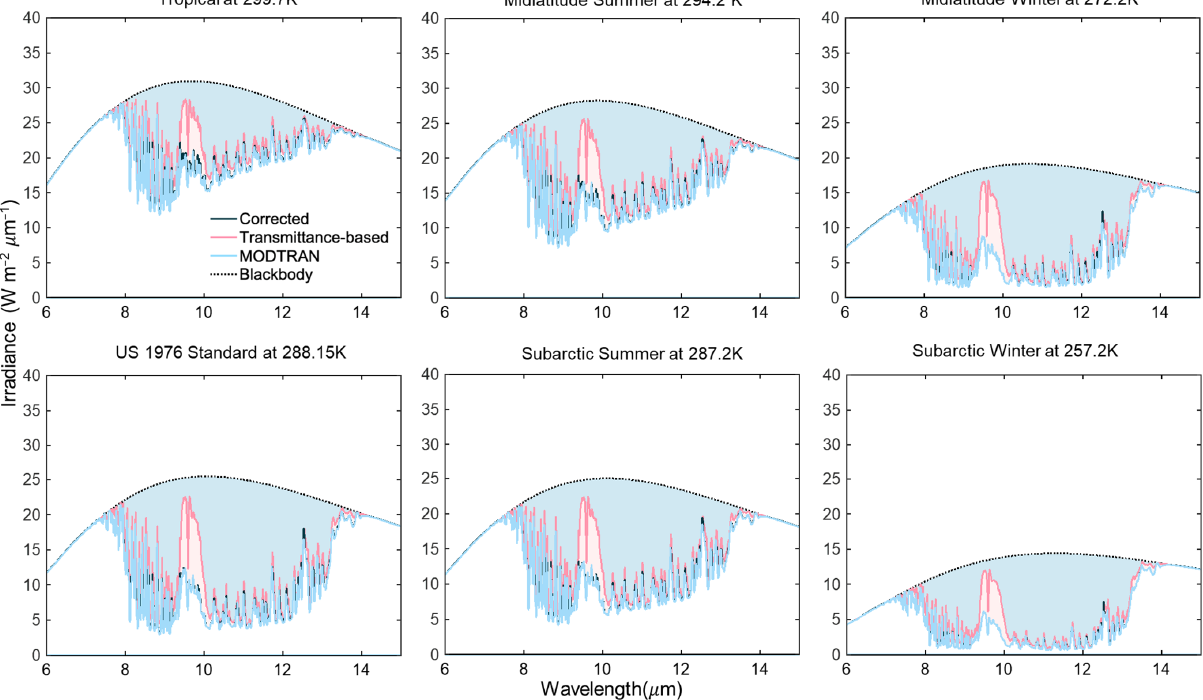
Figure 3. Spectral hemispherical atmospheric irradiance I atm for the transmittance-based model and our corrected model for the standard MODTRAN atmospheres.